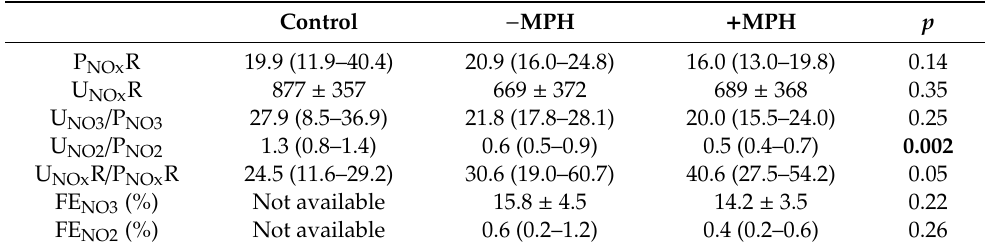
Table 3. Molar ratios of nitrate, nitrite and creatinine in plasma (P) and urine (U), and fractional excretion (FE) in controls and ADHD children without ( − MPH) and with ( + MPH) methylphenidate (MPH)